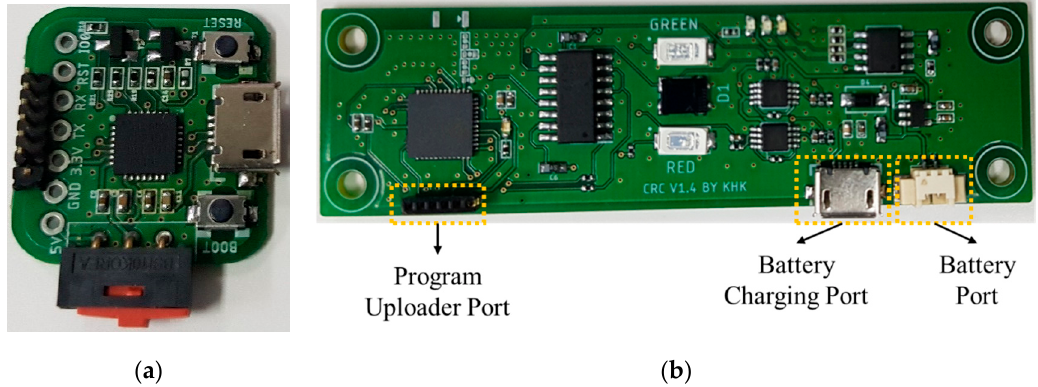
Figure 18. Implementation of the wearable version of the PO system. PCB, printed circuit board. ( a ) Serial Converter ( b ) PCB.